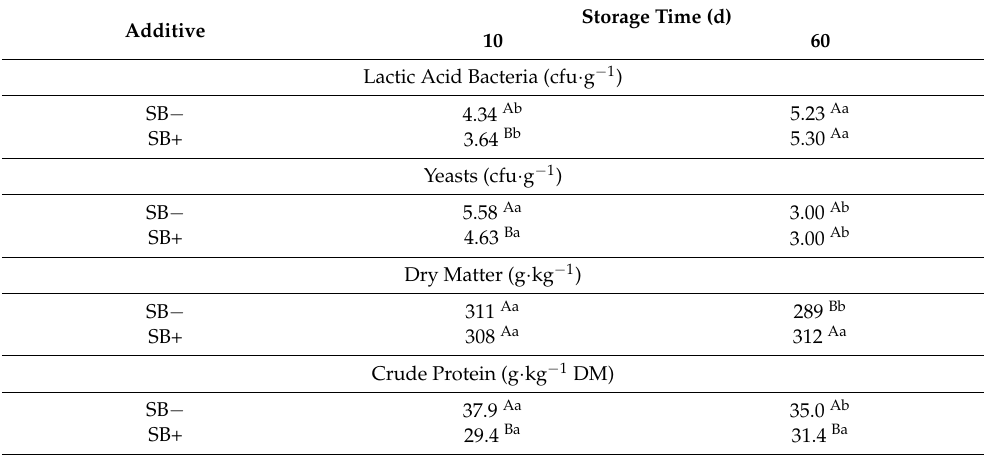
Table 4. The effects of the additive application and storage time interaction (SB × ST) on sugar- cane